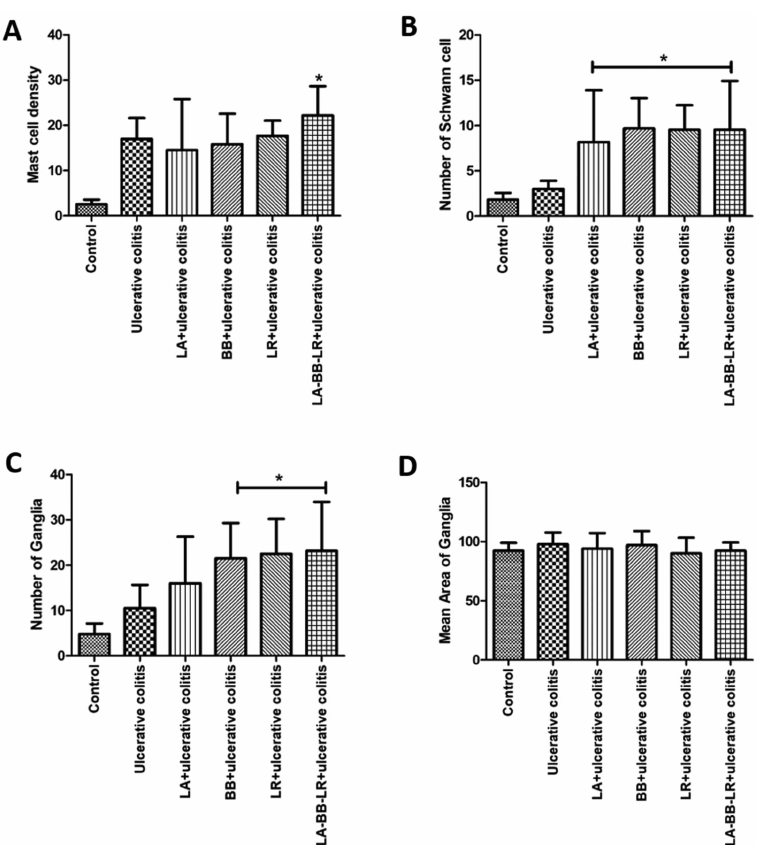
Figure 2. Diagram showing mast cell density, Schwann cell number, number of ganglia, and mean area of ganglia. (A) Mast cell density. *Indicates a significant difference compared to the control and ulcerative colitis group (group 2) ( P < .05). (B) Number of Schwann cell. *Indicates a significant difference compared to the control and ulcerative colitis group (group 2) ( P < .05). (C) Number of ganglia. *Indicates a significant difference compared to the control and ulcerative colitis group (group 2) ( P < .05). (D) Mean area of ganglia. There was no statistically significant difference between the groups and compared to the control